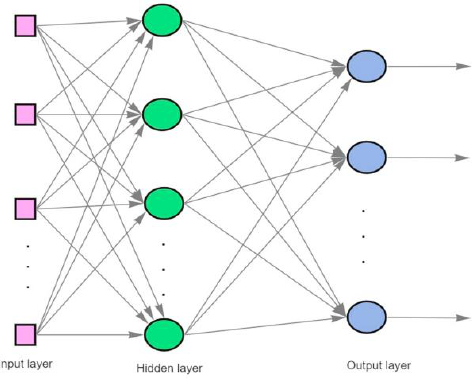
Figure 8. Multiple Adaptive Linear Element (MADALINE) model.